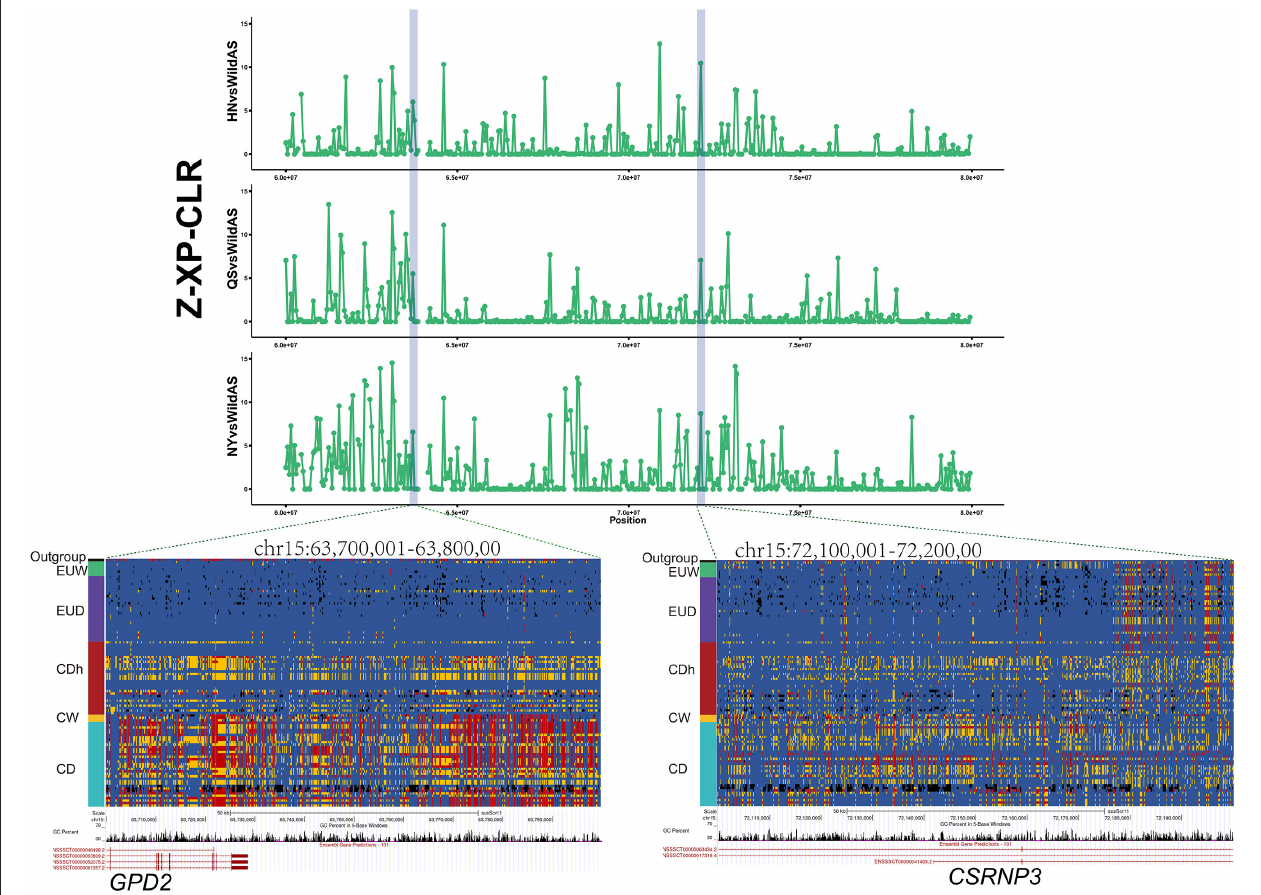
FIGURE 5 | Introgression at the GPD2 and CSRNP3 loci. XP-CLR showed significant selection signatures located in the GPD2 and CSRNP3 genes in Henan indigenous pigs compared to Chinese wild pigs. Results from genotyping a diverse panel of European and Chinese pigs for SNPs in the putative selective sweeps containing GPD2 or CSRNP3